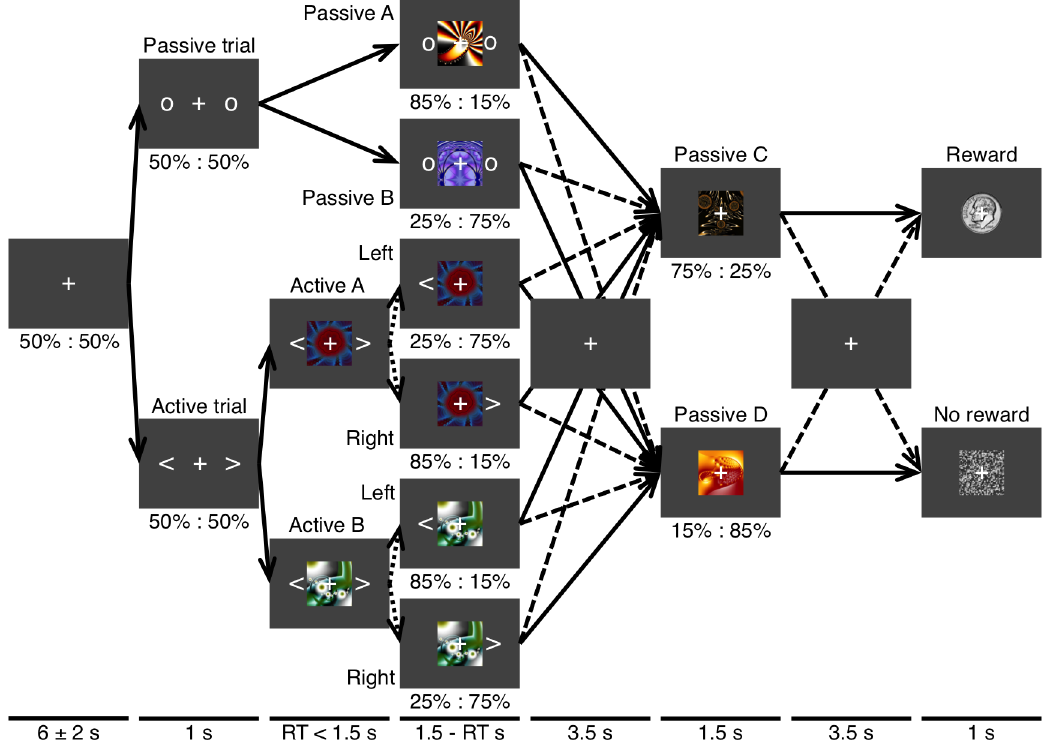
Fig 1. Markovdecisionprocess. Thisschematicof the taskillustratesthe transitionprobabilities for a Markovdecision processfeaturinginterleavedandinterrelatedpassiveandactivestates.Passiveandactivetypesof trialsoccurredwith equalprobability.On a passivetrialthe initialpresentationof twocircleswasfollowedbyoneoftwofractalcuesthateach representeda first-stagepassivestate.The transitionprobabilitiesfor the first-stagestatedeterminedwhichof twosecond- stagepassivestates(i.e., fractals) wereto bepresentednext.Thetransitionprobabilitiesfor thetwosecond-stagestates determined whetherthefinaloutcomewasa monetary rewardornothing.On anactivetrial,twoarrowswerefollowedby oneoftwofractalsthateachrepresenteda first-stageactivestate.The transition probabilitiesfor anactiongiventhe state determined whichof thesamepairofsecond-stagepassivestateswasto bepresentednext.Solidlinesrepresenttransitions havinganequalorrelativelygreaterprobabilityof occurring.Dashedlinesrepresenttransitions havinga relativelylower probabilityofoccurring.Dottedlinesrepresenttransitions thataredeterminedbyanaction.The fixationcrossappearedas depictedoneverytrialregardless of whethera givenarrowactuallypassesthroughtherepresentationof aninterstimulus intervalhere.